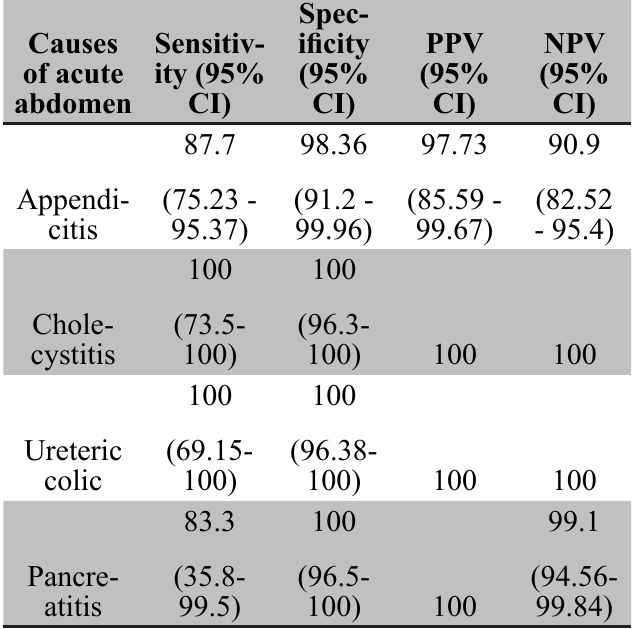
Table 4. Sensitivity and specificity of USG